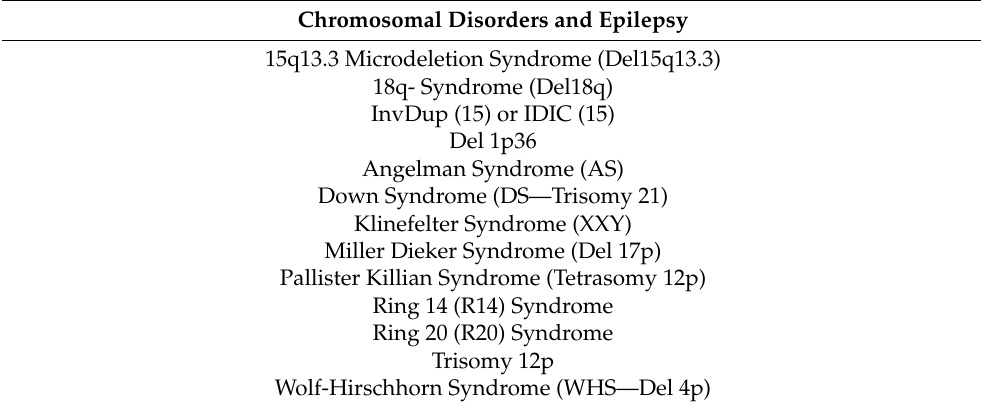
Table 1. Chromosomal disorders associated with epilepsy according to the